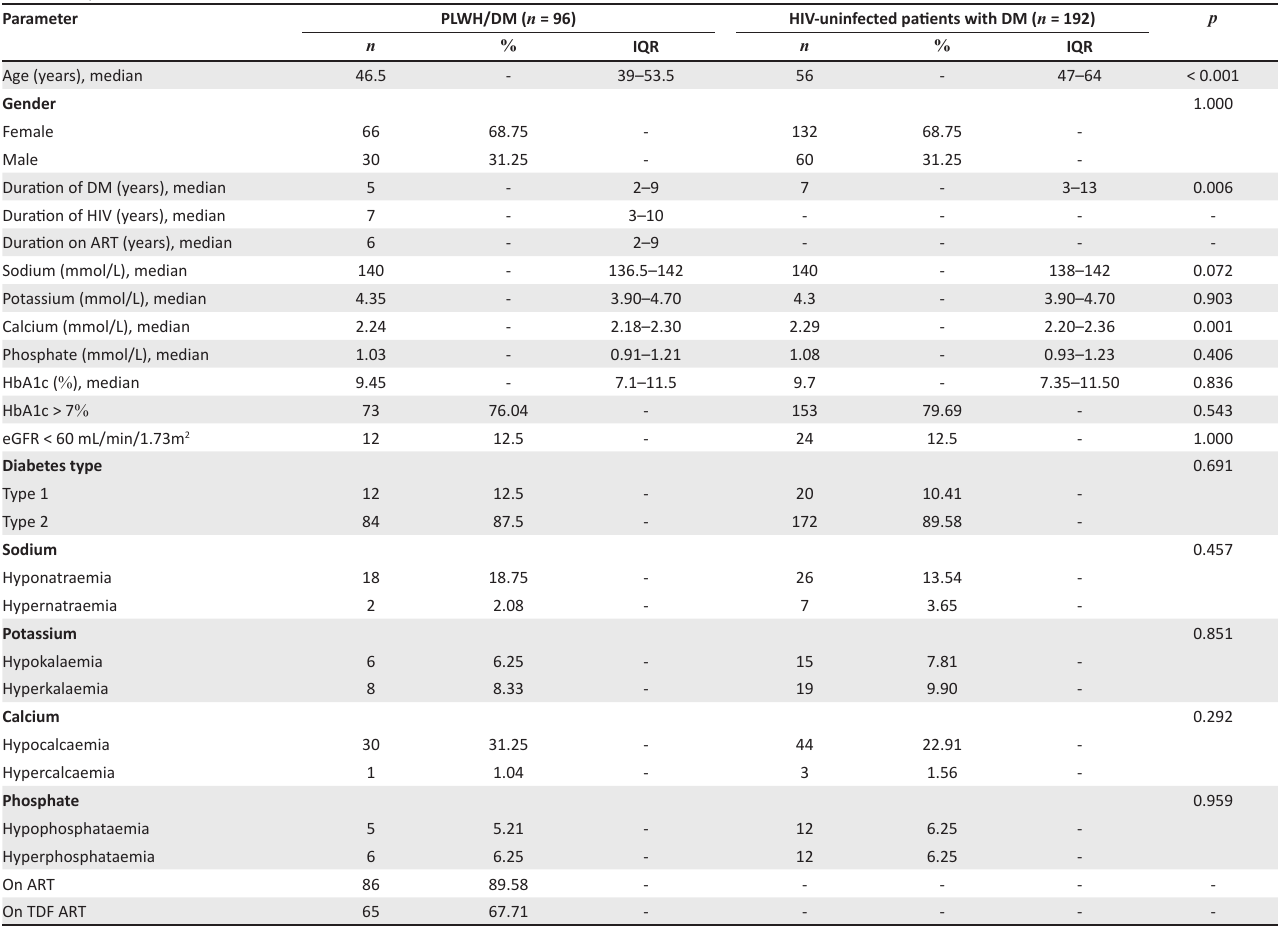
TABLE 1: Demographic and clinical characteristics of people living with human immunodeficiency virus and diabetes mellitus, and human immunodeficiency virus- uninfected patients with diabetes mellitus.